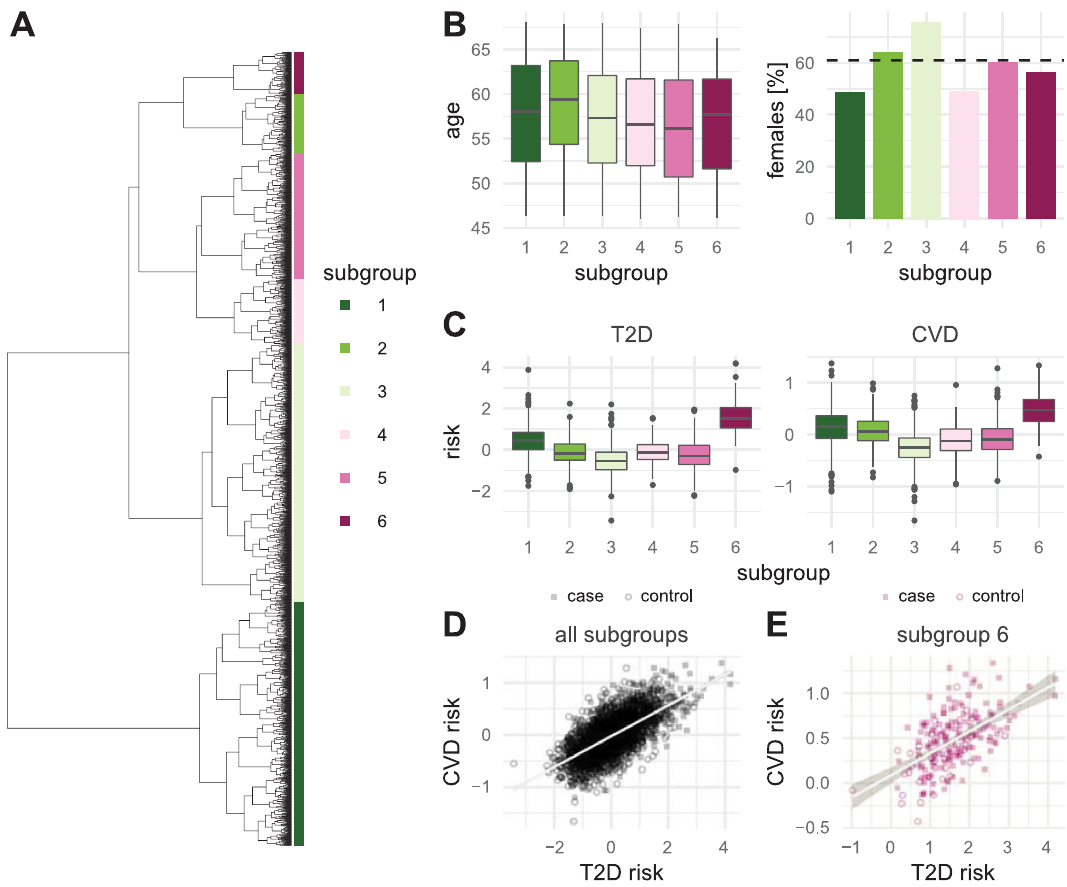
Fig 5. Lipidome-based risk subgroups. Shown is a hierarchical clustering of 3,599 plasma samples that is solely based on 184 lipid concentrations. Pearson correlation has been used as distance measure. The tips of the dendrogram are colored according to the 6 subgroups obtained by splitting the dendrogram into the 6 most basal clusters. (B) Distribution of age (left) and sex (right) in the 6 subgroups. The dashed horizontal line indicates the average female percentage in the full cohort. (C) Distribution of L risk scores for the 6 subgroups for T2D (left) and CVD (right). (D) The 2 risk scores for T2D and CVD are compared for all participants; note that cases are defined here as being either a T2D or CVD incidence. The line indicates a least squares fit of a linear model to the data; Pearson’s r = 0.613. (E) Same as C but only for participants belonging to subgroup 6; Pearson’s r = 0.504. The data underlying this figure may be found in S1 Data. CVD, cardiovascular disease; T2D, type 2 diabetes.